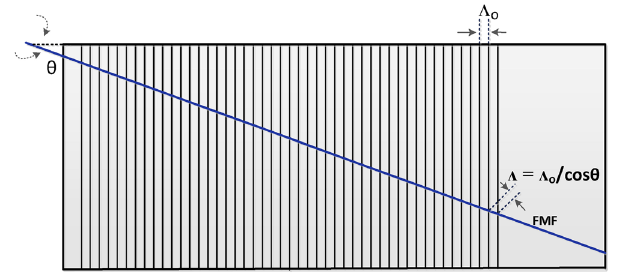
Figure 7. Positioning of the fiber at different angles w.r.t. LPFG (top view with angle θ ) to vary the